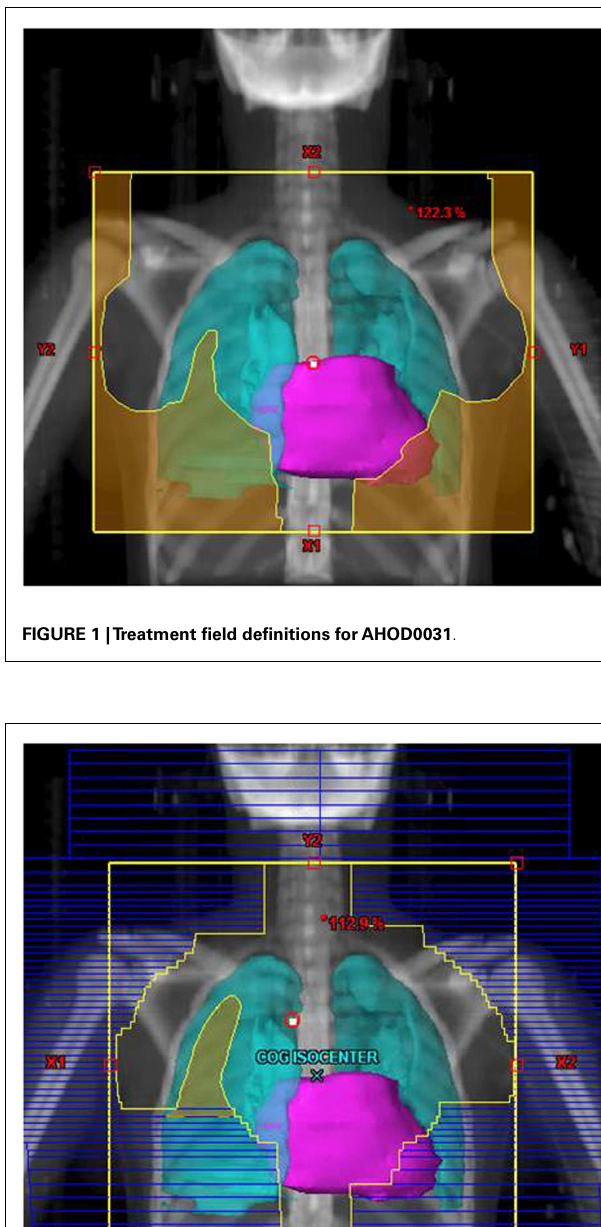
patients met the criteria of 5 cm, disease in the mediastinum, and would have required RT on ECOG Arm B, but only 4 (including 3 females) had mediastinal disease > 1/3 chest diameter and would have required RT on ECOG Arm A. Therefore, it was decided to exclude Arm A from the analysis due to insufficient statistical power ( Table 2